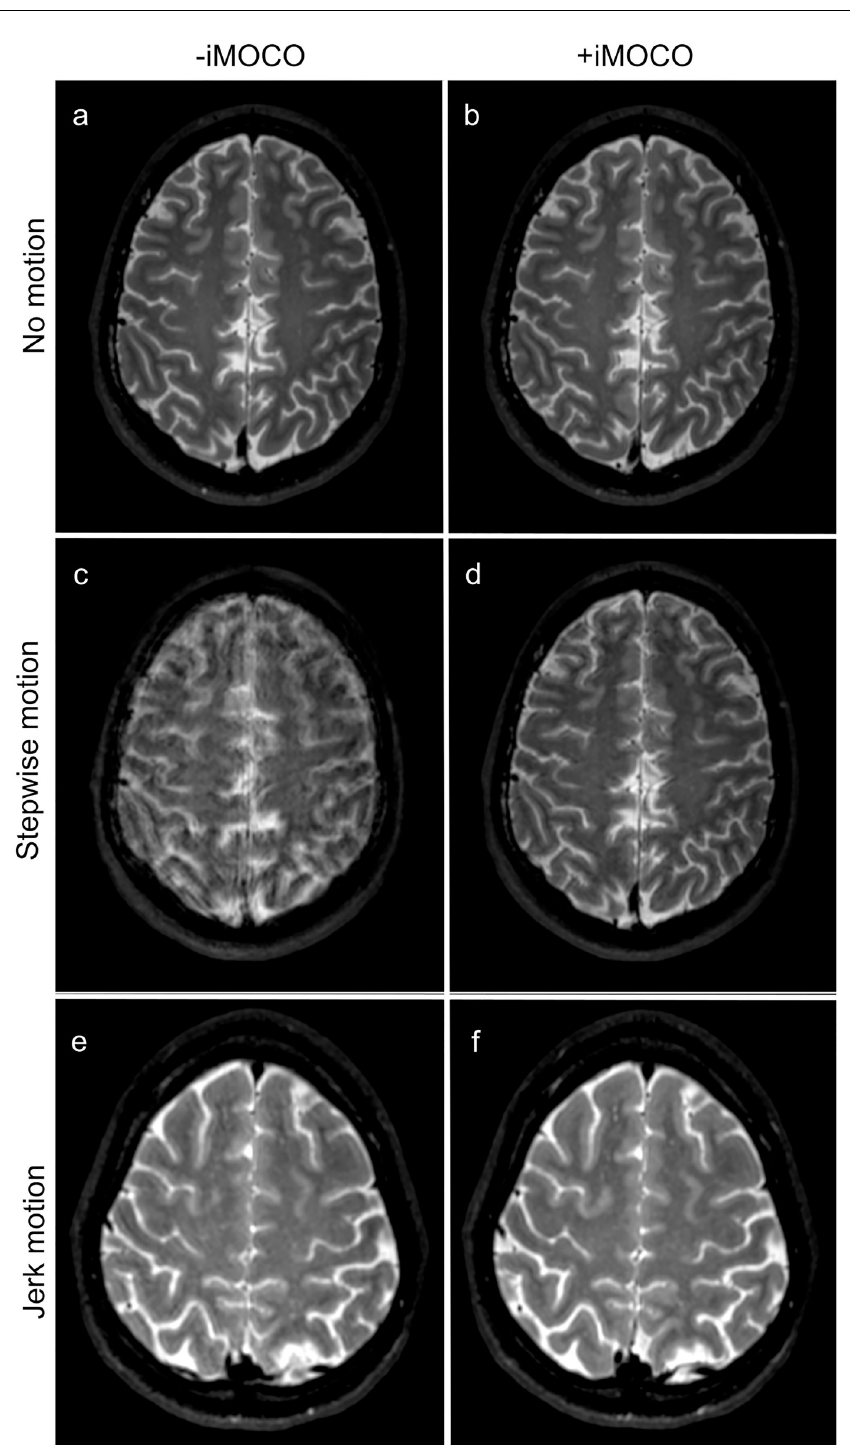
Fig 3. Examples of T2-weighted scans with (+) and without (-) iMOCO for different types of movement. Panels a– d are from subject 1, whereas panels e and f are from subject 5. The scans in a and b were given a grading of 3 in all quality criteria except for two scored structures that are not illustrated (insula, extreme capsule, and claustrum; and putamen), which received a grading of 2. The scan in panel c was graded 1 in all criteria, whereas panel d was given a grading of 2 in all criteria except for frontal horn and septum pellucidum (both not illustrated), which were graded 3. With jerk motion, the artefacts were less problematic, and the scan represented in e was given a grading of 2 in all criteria while f was graded